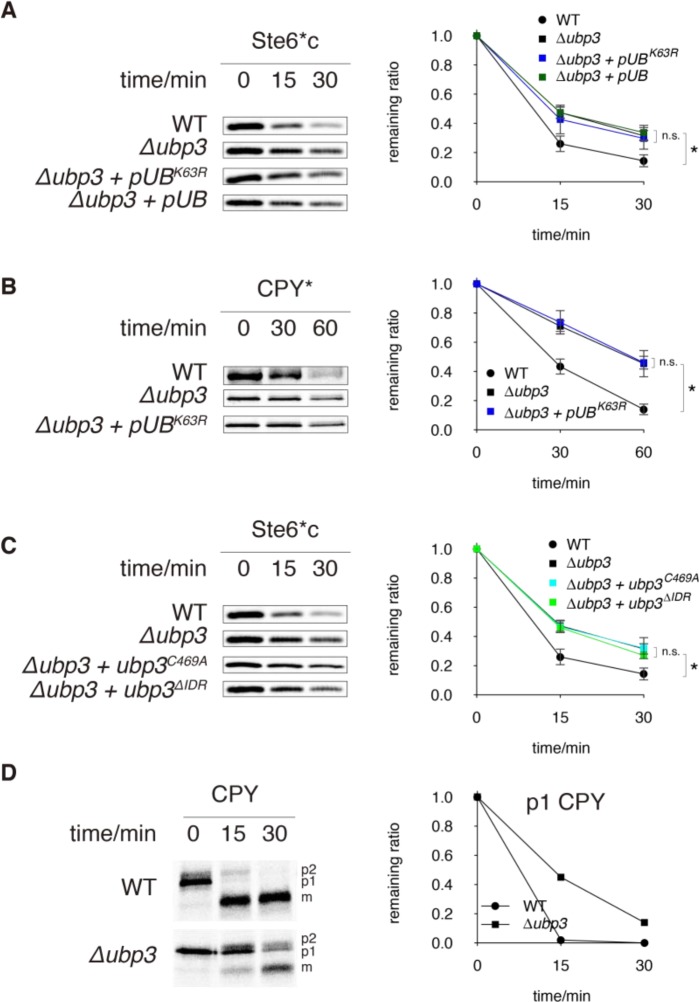
Ubp3 supports QC by distinct mechanisms.(A) Degradation of Ste6*c in Δubp3 + pUBK63R and Δubp3 + pUB, assayed by pulse-chase as in Fig 2. The turnover curves in WT and Δubp3 are displayed as controls. (B) Degradation of CPY* in Δubp3 + pUBK63R assayed by pulse-chase, shown along with degradation in WT and Δubp3. (C) Degradation of Ste6*c in Δubp3 + ubp3C469A and in Δubp3 + ubp3ΔIDR assayed by pulse-chase, shown along with degradation in WT and Δubp3. (D) Maturation of newly synthesized (WT) CPY, assayed by pulse-chase. p1: ER precursor; p2: precursor that has been transported to and modified by the Golgi; m: mature CPY in vacuole. Graph on the right shows the quantification of p1 CPY at different time-points. Experiment was performed only once.